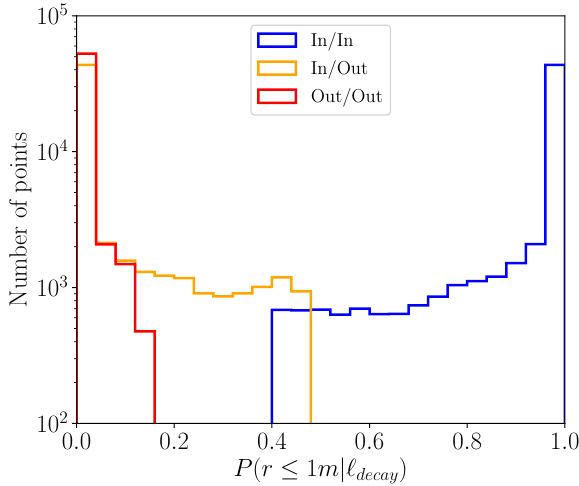
Figure 14 . Probability that a pair of ALPs coming from the decay of a heavy particle decays both within 1 meter inside the detector (In/In), both outside 1 meter inside the decetor (Out/Out), and one before 1 meter and the other after 1 meter inside the detector, given the decay length in the laboratory frame, ‘ decay